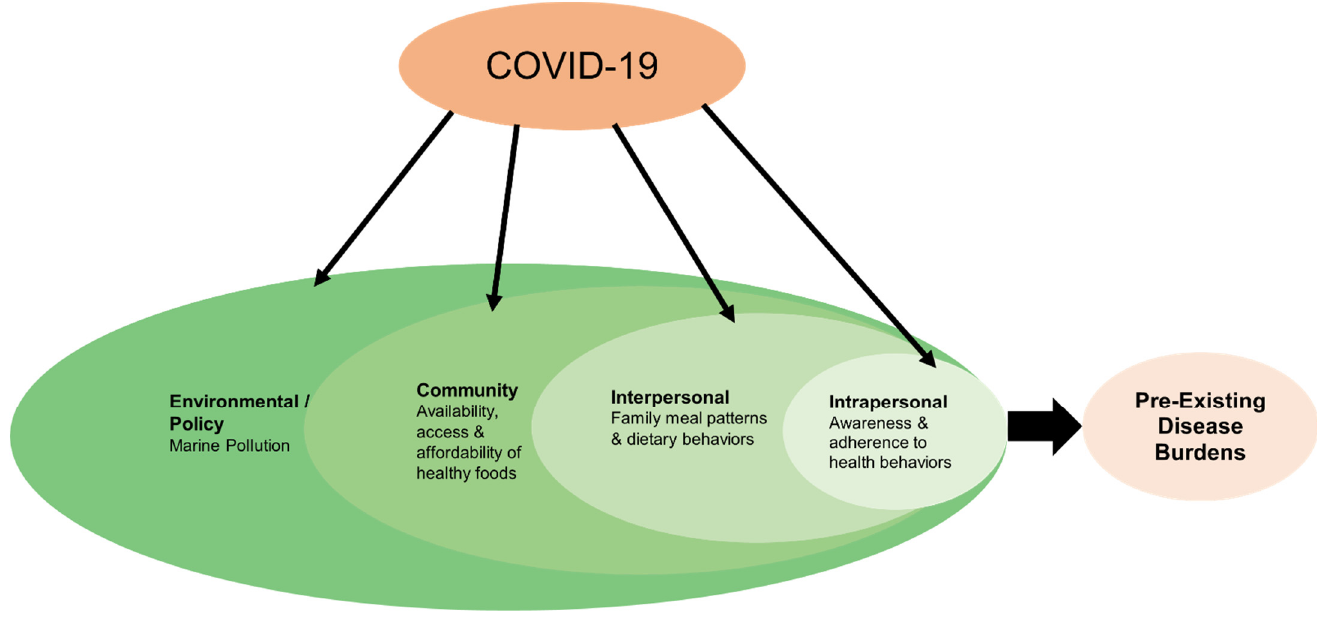
Figure 1. Socio-ecological model of COVID-19 impacts on dietary behaviors and disease risk factors in Indonesia.